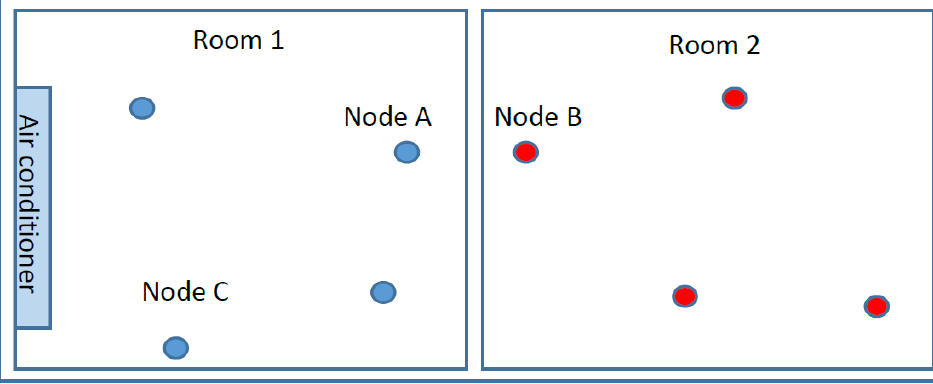
Figure 1. The layout of sensor nodes in an environment with two different conditions area.